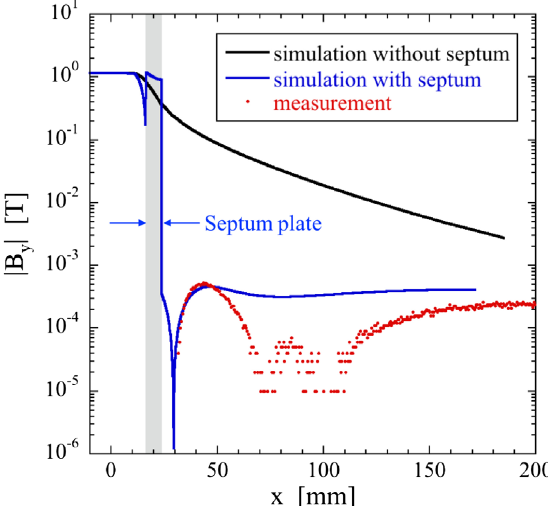
FIG. 14. Transverse distribution of magnetic flux density at the longitudinal center (z ¼ 0 mm) of the dc septum. Black and blue lines represent the simulated distribution without and with the septum plate, respectively. Red dots represent the measured data with the septum plate. The origin of horizontal axis is defined at the incident beam position. The septum plate occupies the position between x ¼ 15 and 22 mm.